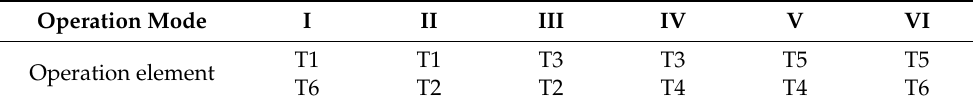
Figure 3. Three-phase BLDC six-step inverter circuit and the TSLM. Table 1. Operation sequences of six step.